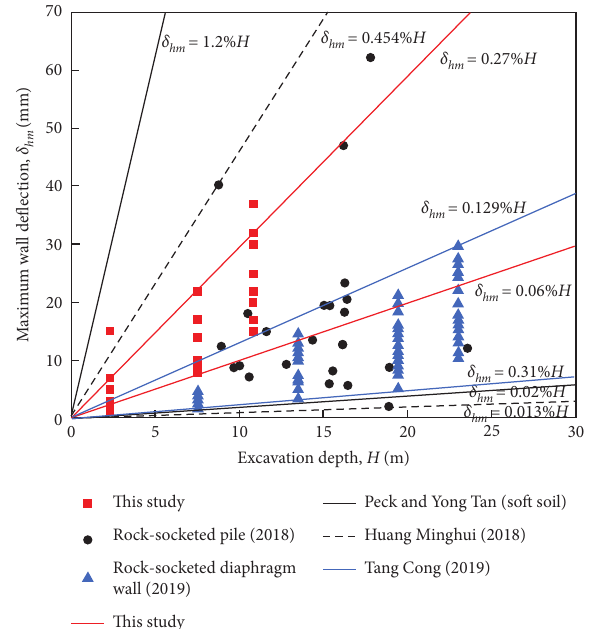
Figure 6: The relationships between H and δ